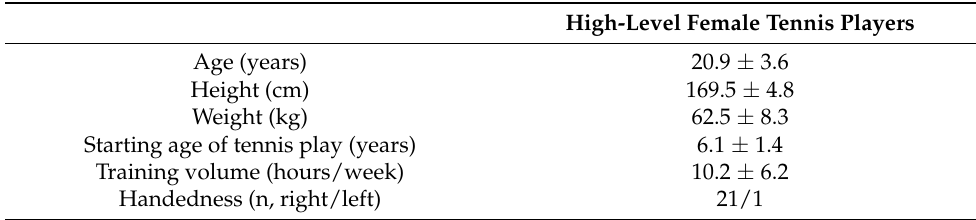
Table 1. Demographic, sport-specific and anthropometric information of the high-level female tennis players (N =